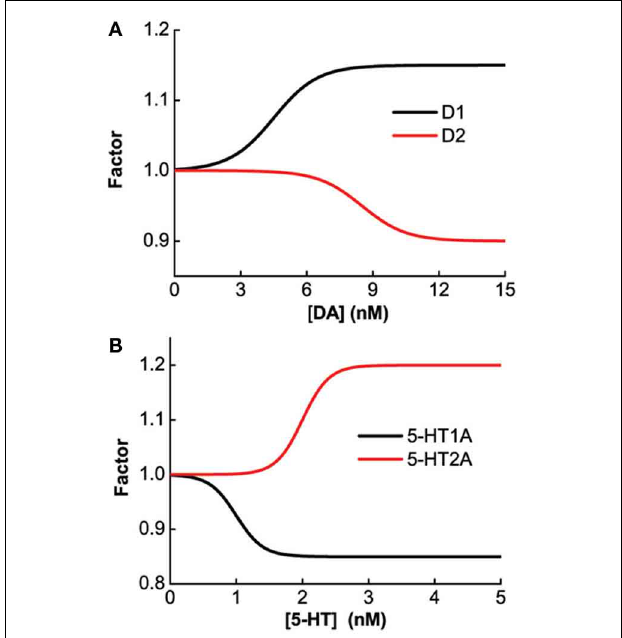
FIGURE 1 | Concentration dependent modulation factor of DA and 5-HT. Black (red) line: gain modulation factor due to D1 (D2) receptors as a function of DA concentration (A) ; modulation factor due to 5-HT1A (5-HT2A) receptors as a function of 5-HT concentration (B) .